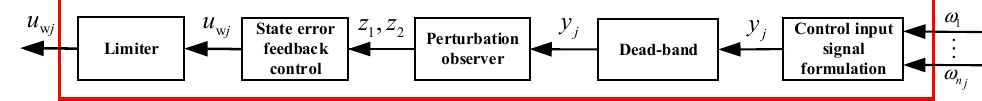
Figure 5. The block diagram of PEC.